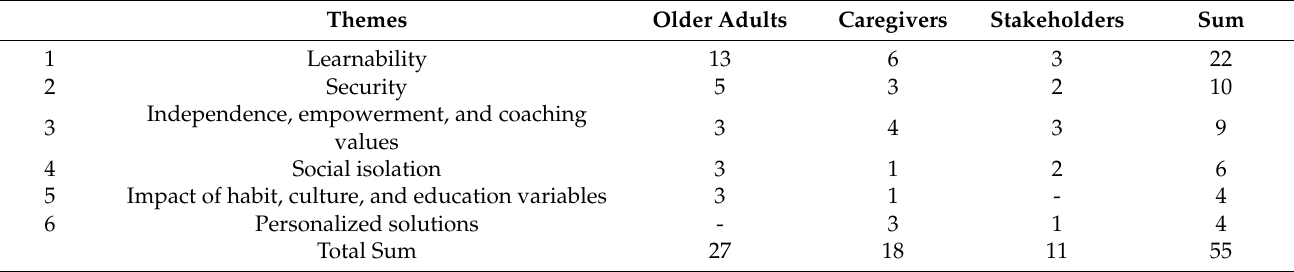
Table 2. Themes arising from the thematic analysis per group of